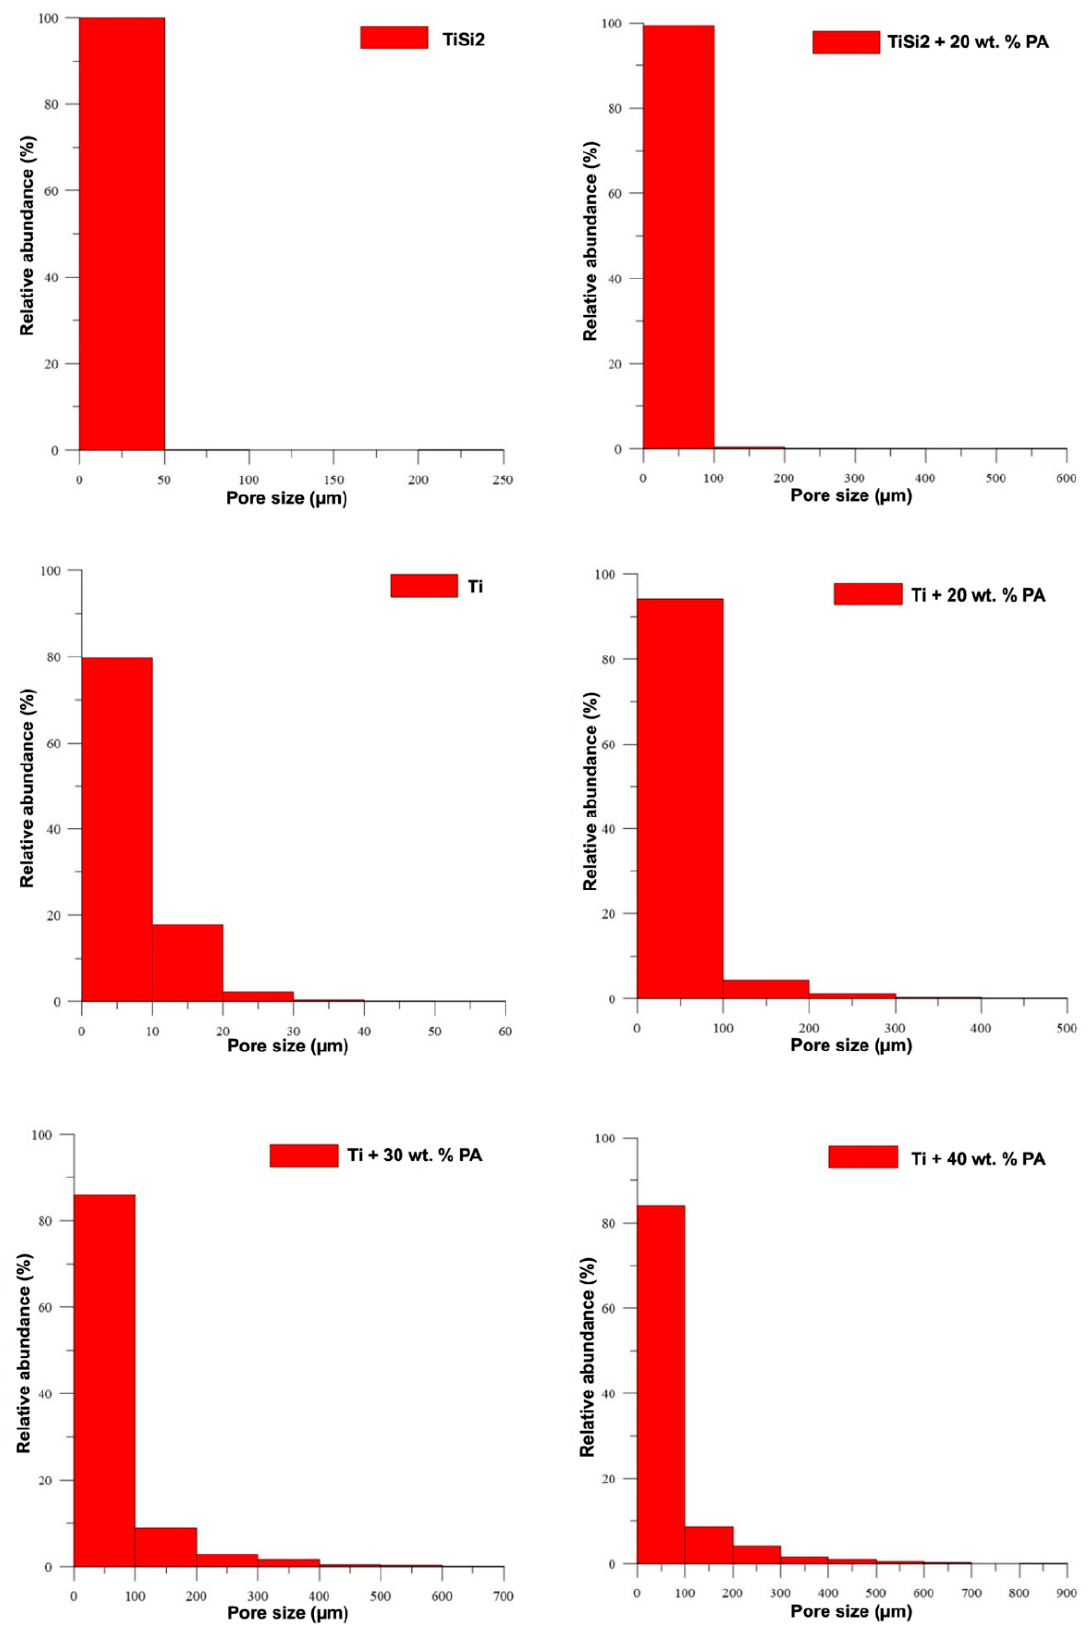
Figure 3. Relative representation of pore size.